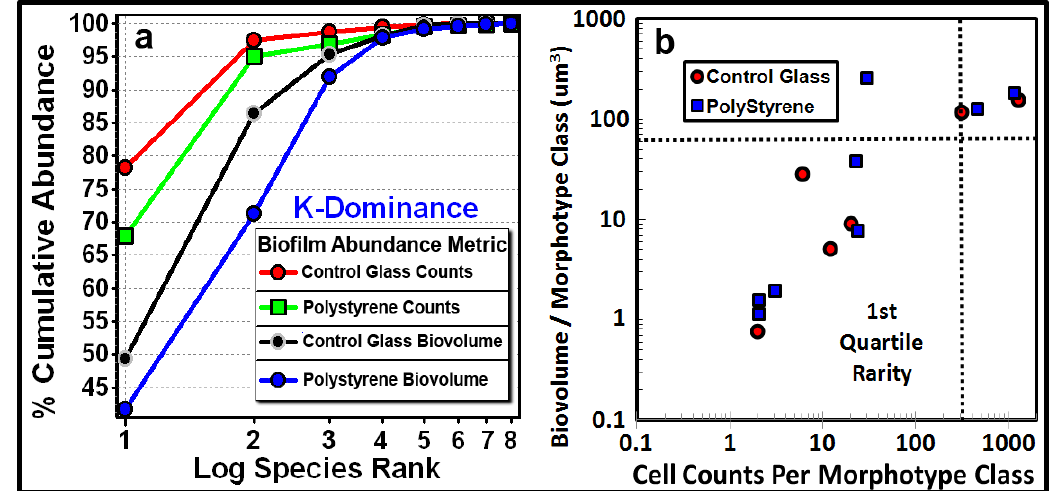
Figure 4. ( a ) K-Dominance and ( b ) Quartile Rarity scatter plots that compare the extent of dominant and rare morphotype classes within the communities. Dotted lines in 4 b indicate the 25th percentile for both axes that define the first quartile of rare morphotype